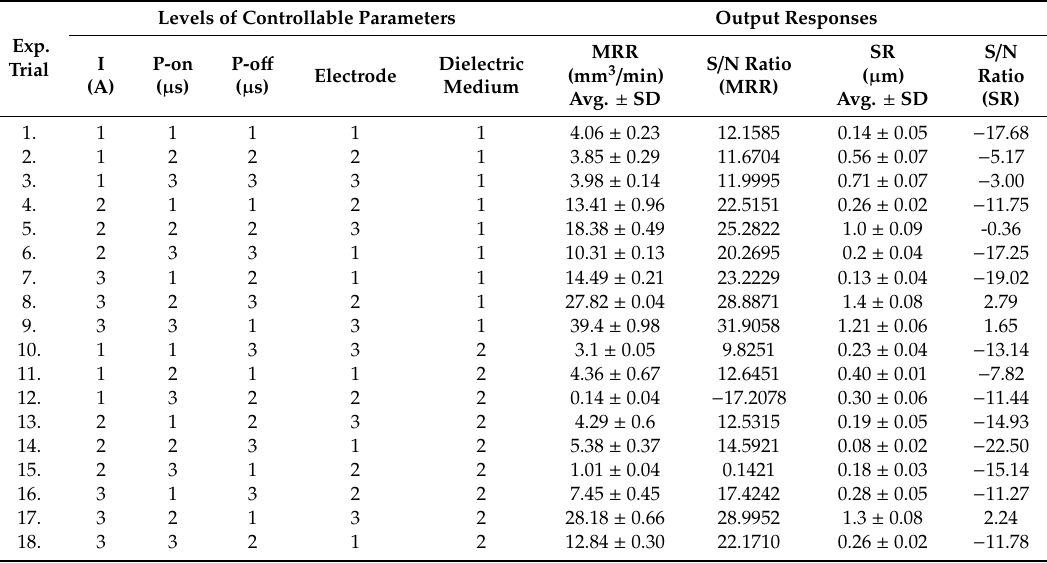
Table 3. Experimental L18 array design matrix and output response observations.